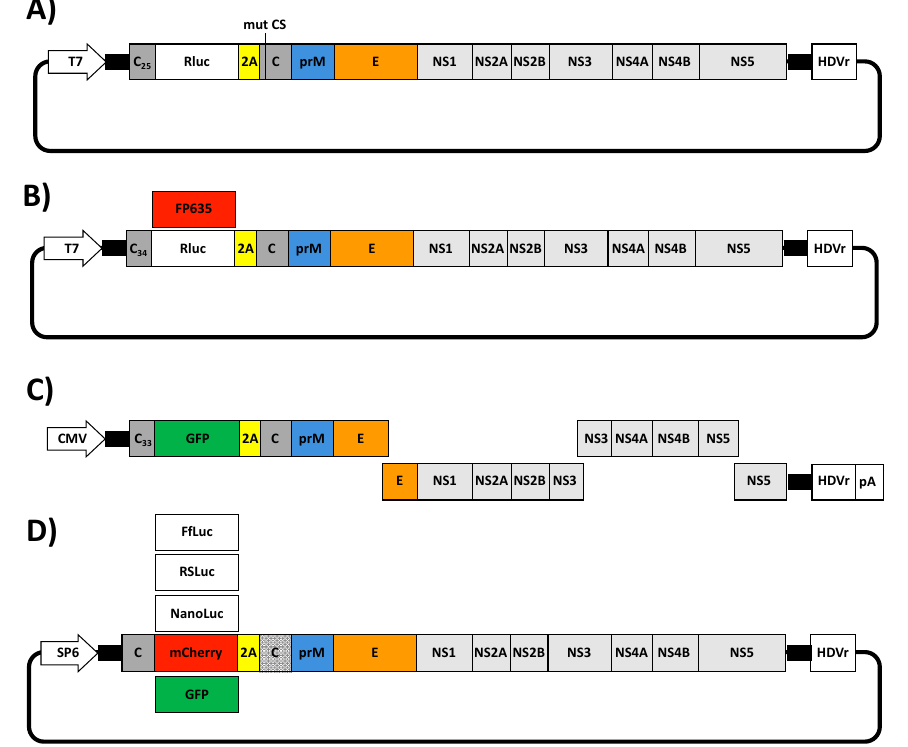
Figure 5. Reporter gene-expressing rZIKVs. ( A ) Schematic diagram of a Rluc-expressing ZIKV cDNA clone: A full-length cDNA clone expressing the Rluc reporter gene (white box) was constructed by Shan et al. [46]. Rluc was introduced downstream of the first 25 amino acids of the C protein (C 25 , dark gray) followed by the FMDV 2A protease sequence (yellow box) fused in-frame with the viral ORF. Silent mutations changing the flavivirus-cyclization sequence were introduced in the full-length C protein (mut CS). ( B ) Schematic representation of a full-length ZIKV cDNA expressing Rluc or FP635: Full-length cDNA clones expressing Rluc (white box) or FP635 (red box) were generated by Münters et al. [50]. Reporter genes were introduced downstream the first 34 amino acid of the C protein (C 34 , dark gray) followed by the FMDV 2A protease sequence in-frame with the viral downstream proteins. ( C ) Schematic diagram of a GFP-expressing ZIKV generated by ISA: A ZIKV cDNA clone expressing GFP was constructed by Gadea et al. [45] using the ISA approach. The GFP was introduced downstream of the first 33 amino acid of the C protein (C 33 , dark gray) followed by the FMDV 2A protease sequence in-frame with the viral ORF. ( D ) Representation of full-length ZIKV cDNAs expressing luciferase and fluorescent proteins: Full-length ZIKV cDNA clones expressing NanoLuc, FfLuc, RSLuc (white boxes), GFP (green box) or mCherry (red box) were constructed by Mutso et al. [48]. Reporter genes were individually introduced downstream of the complete C protein followed by the FMDV 2A protease sequence fused in-frame with the downstream viral ORF. The codon sequence of the downstream copy of the viral C protein was altered to reduce potential recombination (dotted gray). T7 and SP6: prokaryotic T7 or SP6 promoters. CMV: cytomegalovirus promoter. HDVr: Hepatitis delta virus ribozyme sequence. pA: simian virus 40 late polyadenylation signal.